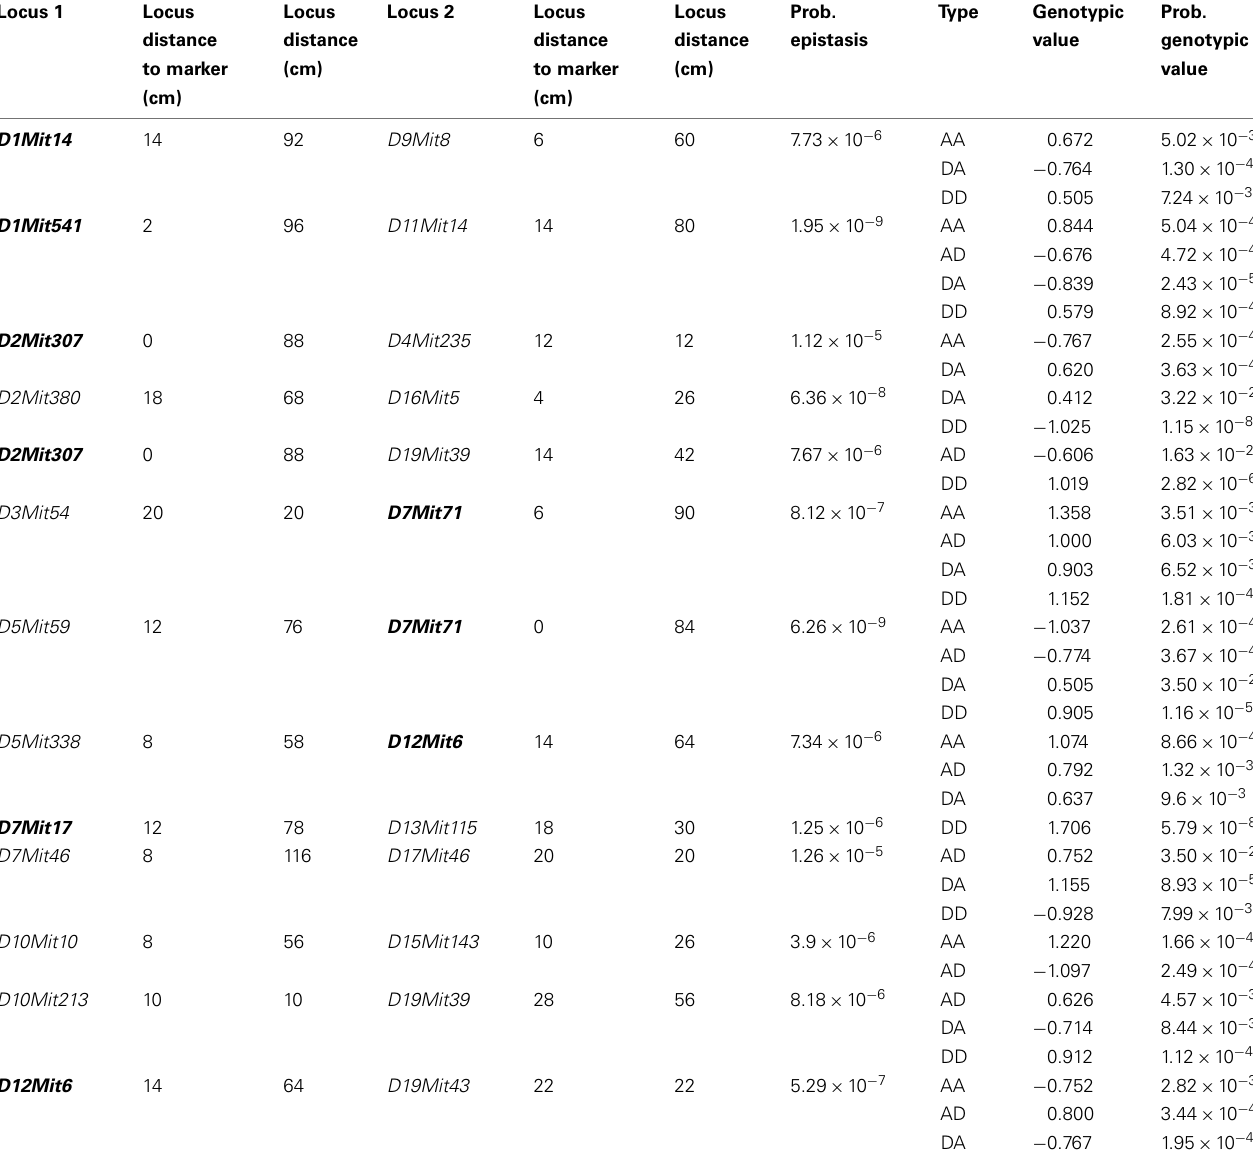
TableA5 | Epistatic QTLs of postpartum nest structure in F 2 females. Locus 1 Locus